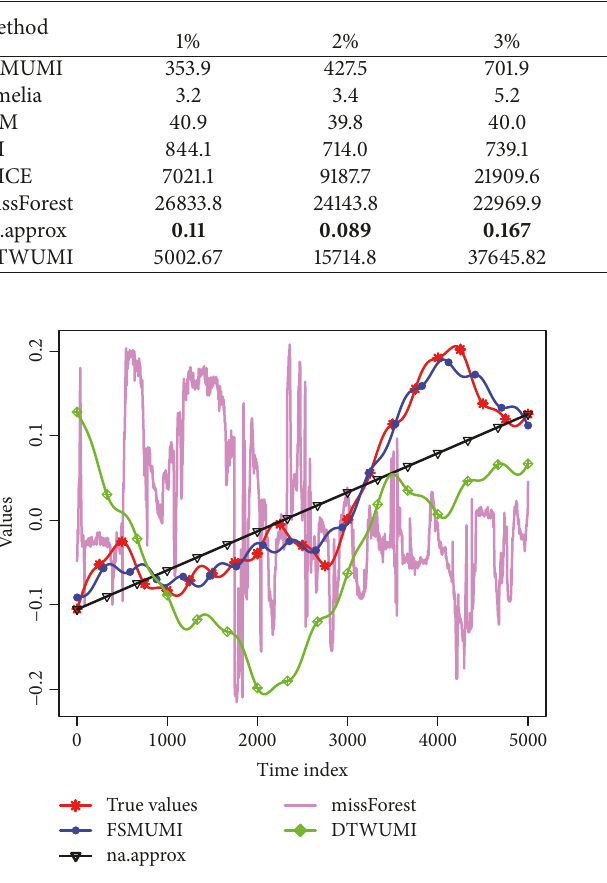
Figure 5: Visual comparison of completion data of different impu- tation approaches with real data on the 1 𝑠𝑡 signal of synthetic series with the gap size of 5000.